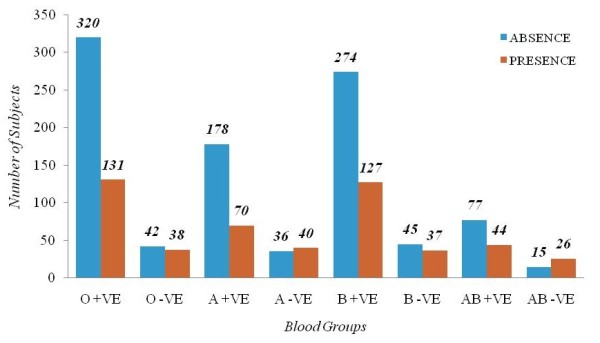
Representation between various blood groups and CHIKV disease of the present study.